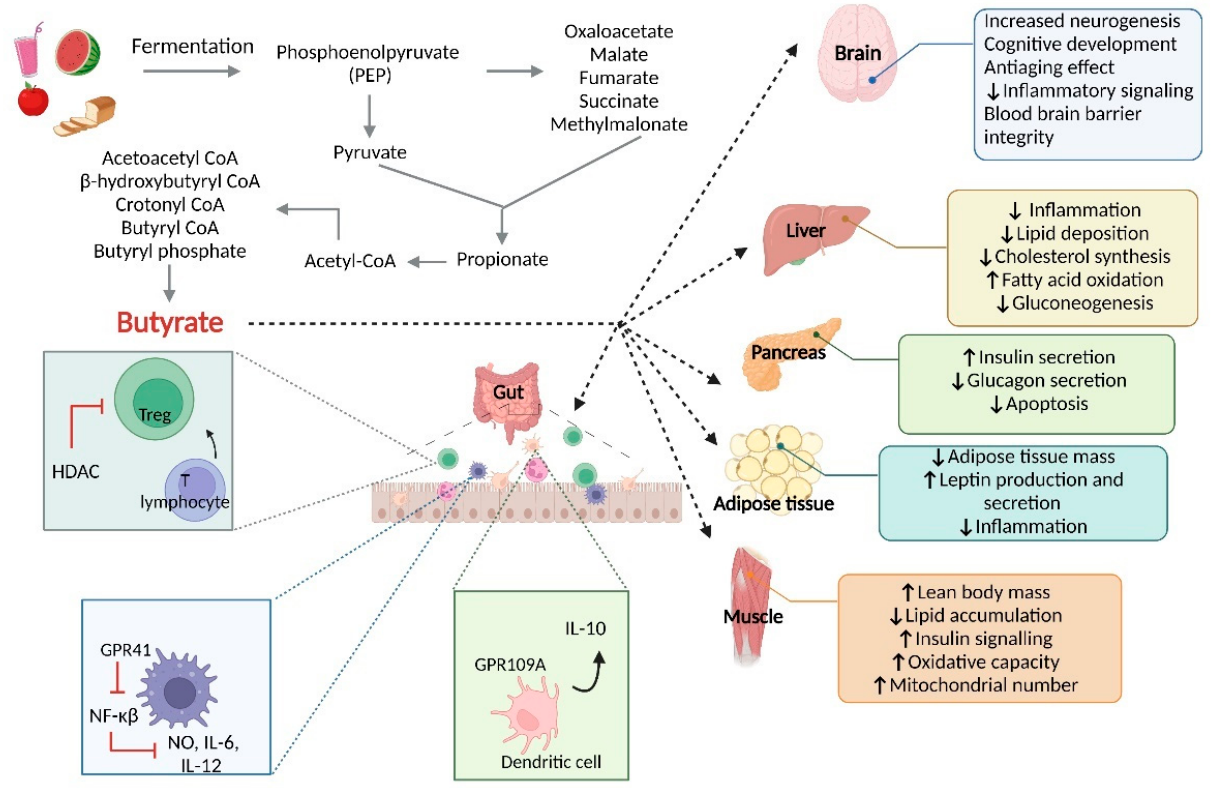
Figure 2. Butyrate synthesis and biological effects. Carbohydrates contained in our daily intake pass through a fermentation process, ending in butyrate production. Butyrate is able to exert various biological effects over a wide range of organs in the organism. Specifically, in the gut, butyrate is able to control the immune response and maintain a tolerogenic profile. IL-10, interleukin 10; IL-6, interleukin 6; NO, nitric oxide; IL-12, interleukin 12; NF- κβ , Nuclear Factor κβ ; HDAC, histone deacetylase.